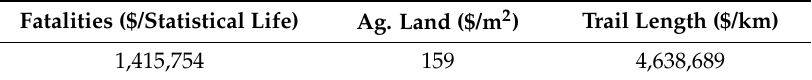
Table 9. Constraining prices for expected avoided damages under which lake lowering (10 or 20 m) is